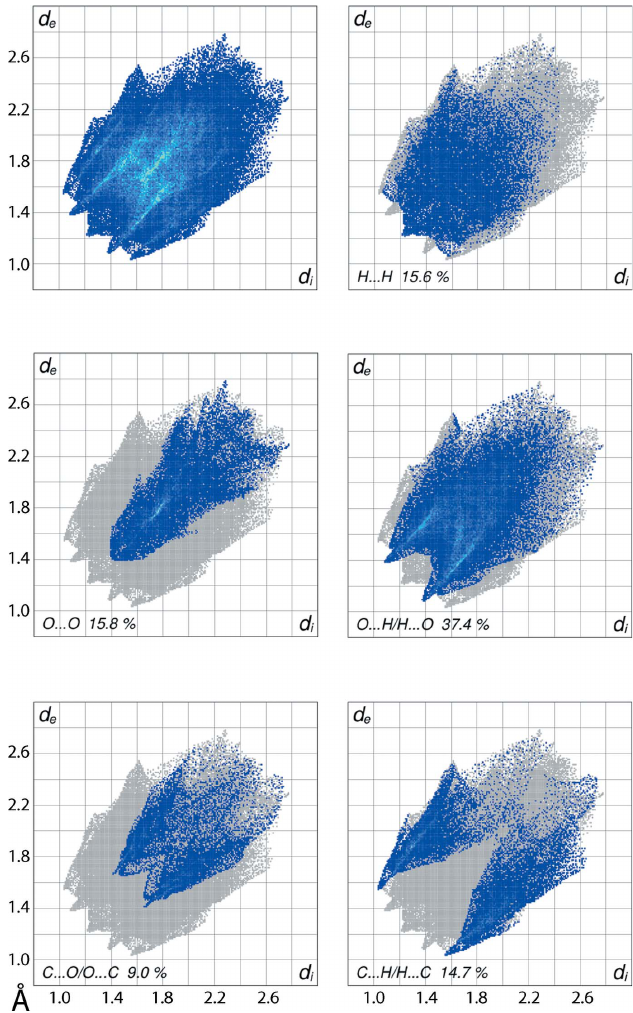
Figure 6 The full two-dimensional fingerprint plot for (I) and those delineated into H (cid:2)(cid:2)(cid:2) H, O (cid:2)(cid:2)(cid:2) H/H (cid:2)(cid:2)(cid:2) O, O (cid:2)(cid:2)(cid:2) O, C (cid:2)(cid:2)(cid:2) H/H (cid:2)(cid:2)(cid:2) C and C (cid:2)(cid:2)(cid:2) O/O (cid:2)(cid:2)(cid:2) C contacts.